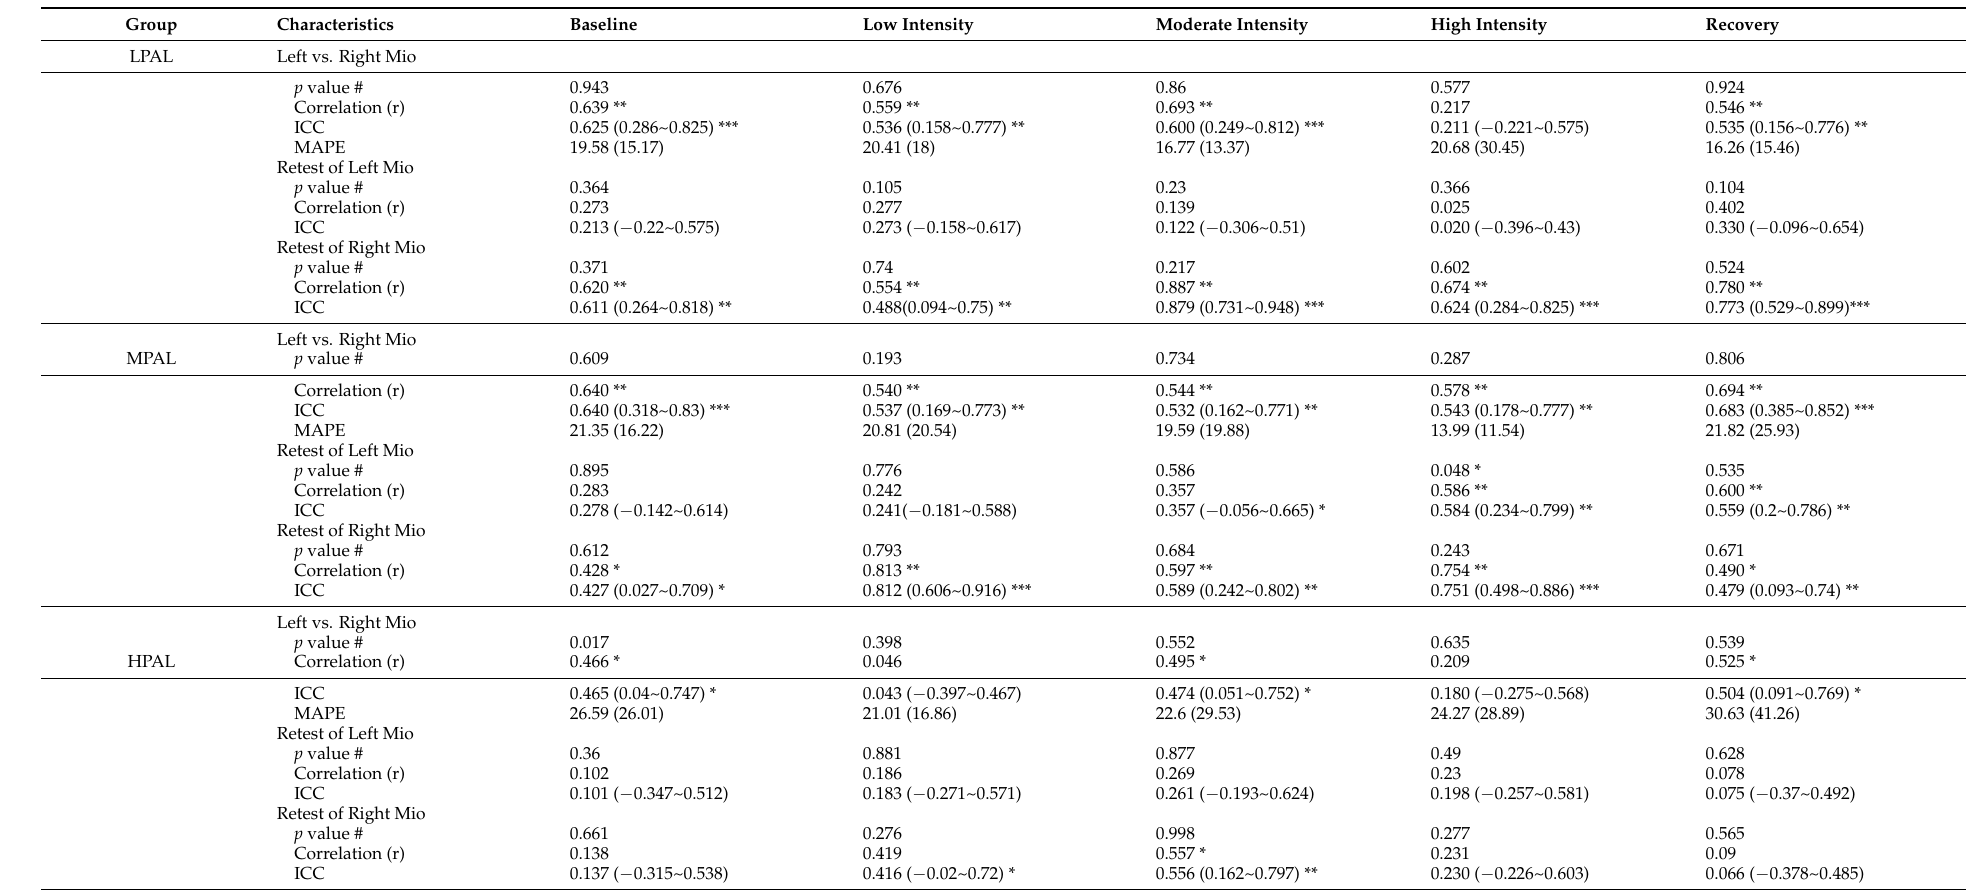
Table 5. Reliability of Mio for